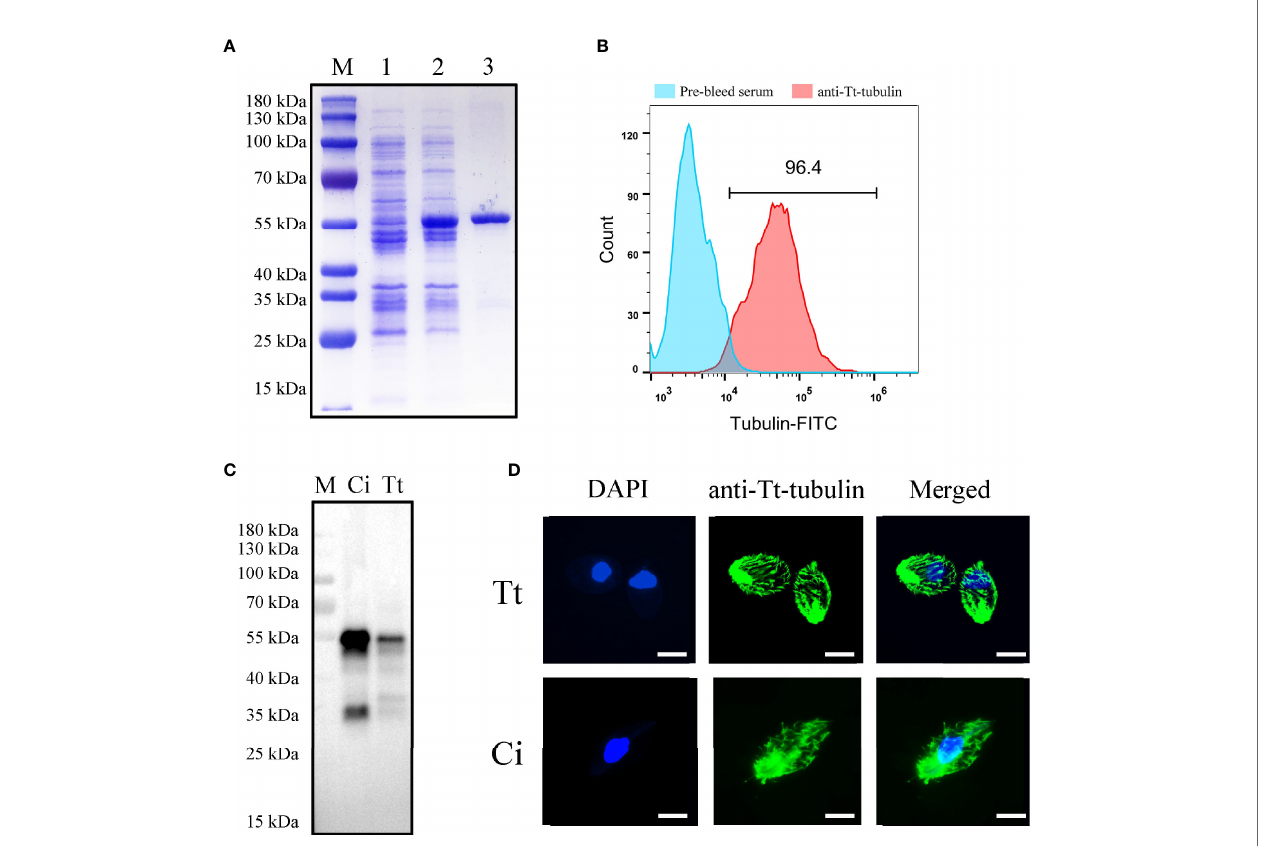
FIGURE 5 | Expression and antibody preparation of T. thermophila tubulin. (A) SDS-PAGE analysis of puri fi ed recombinant T. thermophila tubulin in E. coli . M, protein marker; Lane 1, non-induced BL21 cells transformed with pET32a- D TRX-Tt-tubulin; Lane 2, induced BL21 cells transformed with pET32a- D TRX-Tt-tubulin for 4 h; and Lane 3, puri fi ed recombinant T. thermophila tubulin (approximately 55 kDa) with Ni-NTA. (B) Flow cytometry analysis of C. irritans using the anti – Tt- tubulin antibody. (C) Western blot analysis of total protein from C. irritans and T. thermophila using the anti – Tt-tubulin antibody. (D) Immuno fl uorescence staining of C. irritans and T. thermophila using the anti – Tt-tubulin antibody. Scale bar = 10 m